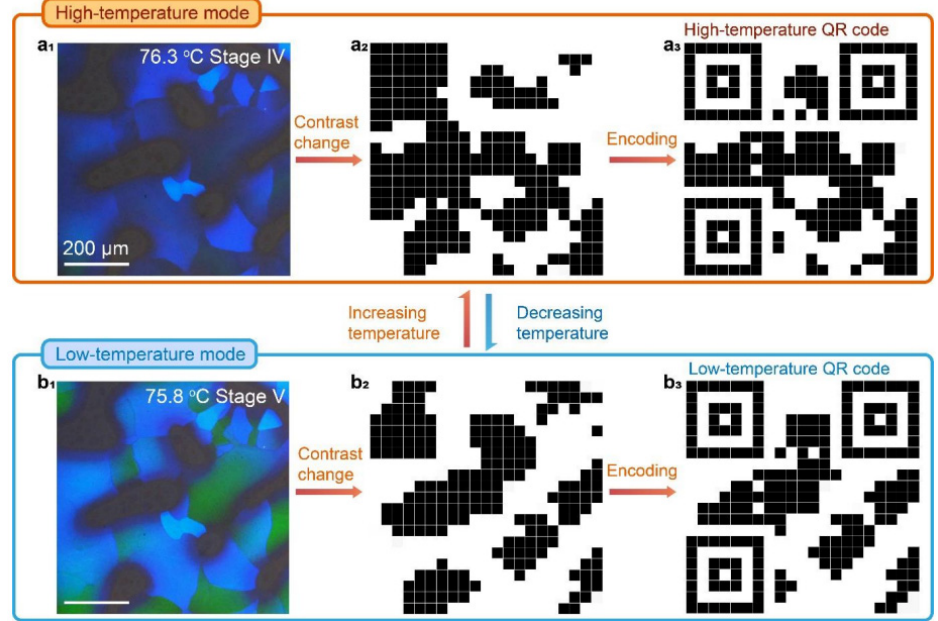
Figure 3. Temperature-controlled BP microscopic QR code transformation [62] . Diffusionless transformation of soft cubic superstructure from amorphous to simple cubic and body-centered cubic phases from L Jiang, Nat Commun; published by Springer Nature.